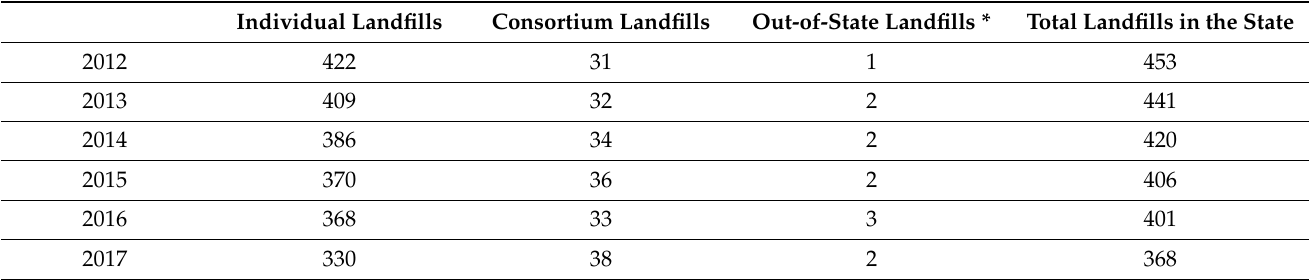
Table 1. MSW disposal sites situation in the S ã o Paulo